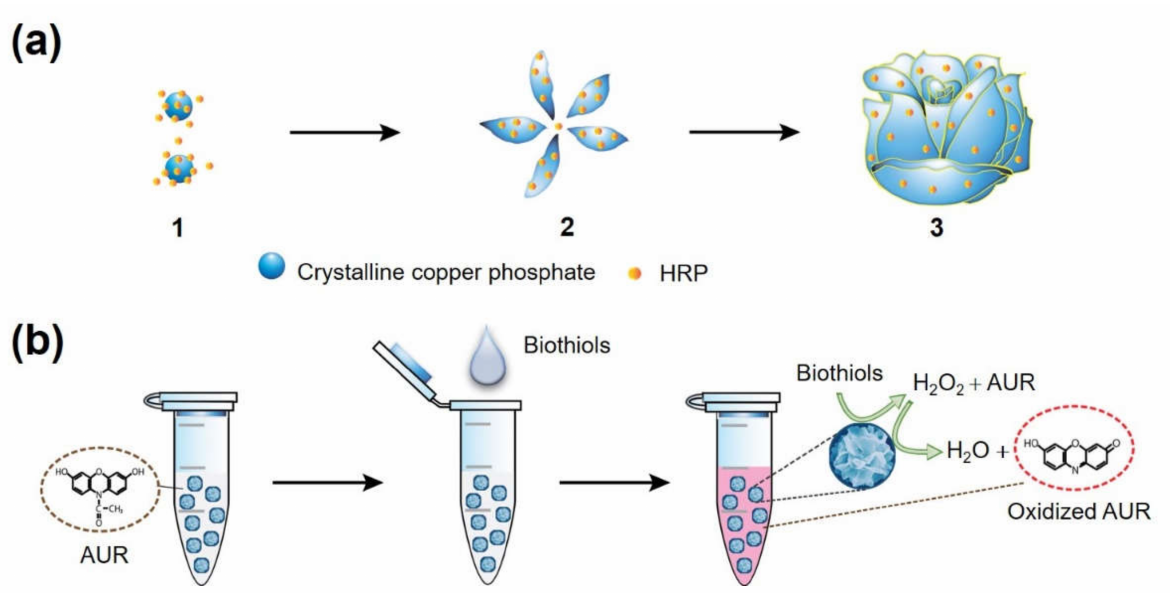
Figure 1. Schematic illustrations for ( a ) the synthesis of HRP-Cu NFs with three stages: (1) nucleation of primary copper phosphate crystals, (2) anisotropic growth of flower petals, and (3) complete formation of the nanoflowers; ( b ) fluorescent one-pot detection of biothiols through the cascade reaction promoted by HRP-Cu